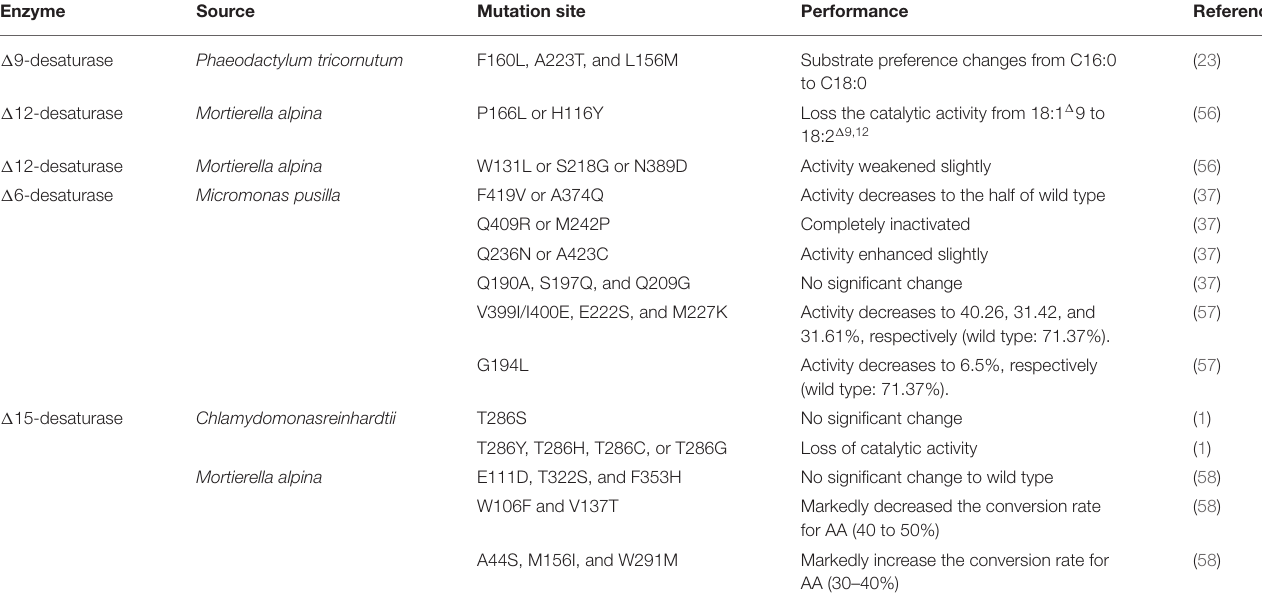
TABLE 2 | The effect of site directed mutagenesis on the performance of desaturase.